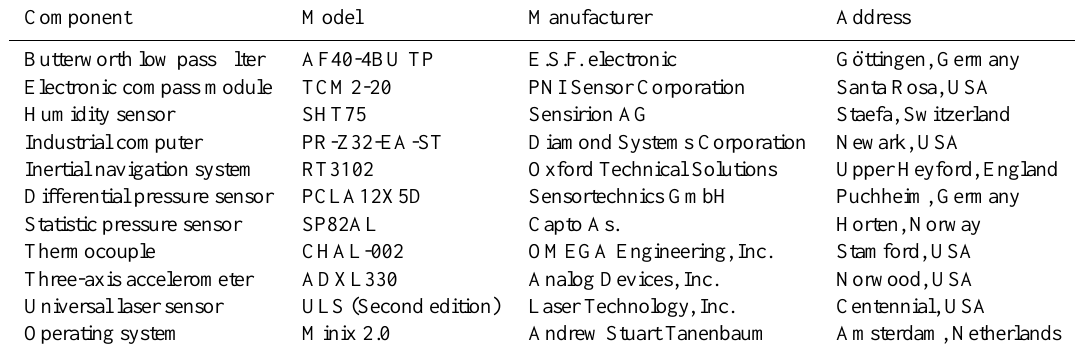
Table 1. Overview of sensors and electronic instrumentation used for the wind